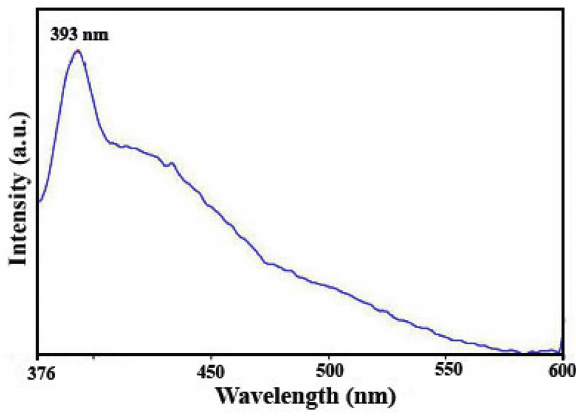
Figure 5: PL spectra of CdS